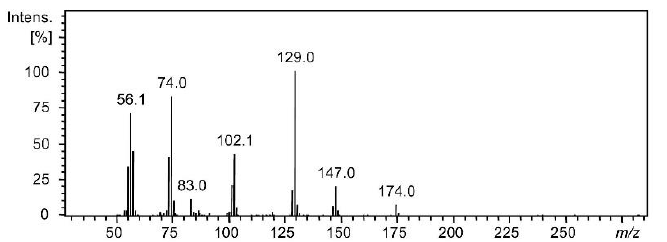
Figure 2. EI mass spectrum of peak of hydrated molecular ion of 4a [M+H 2 O] + • and the range of the